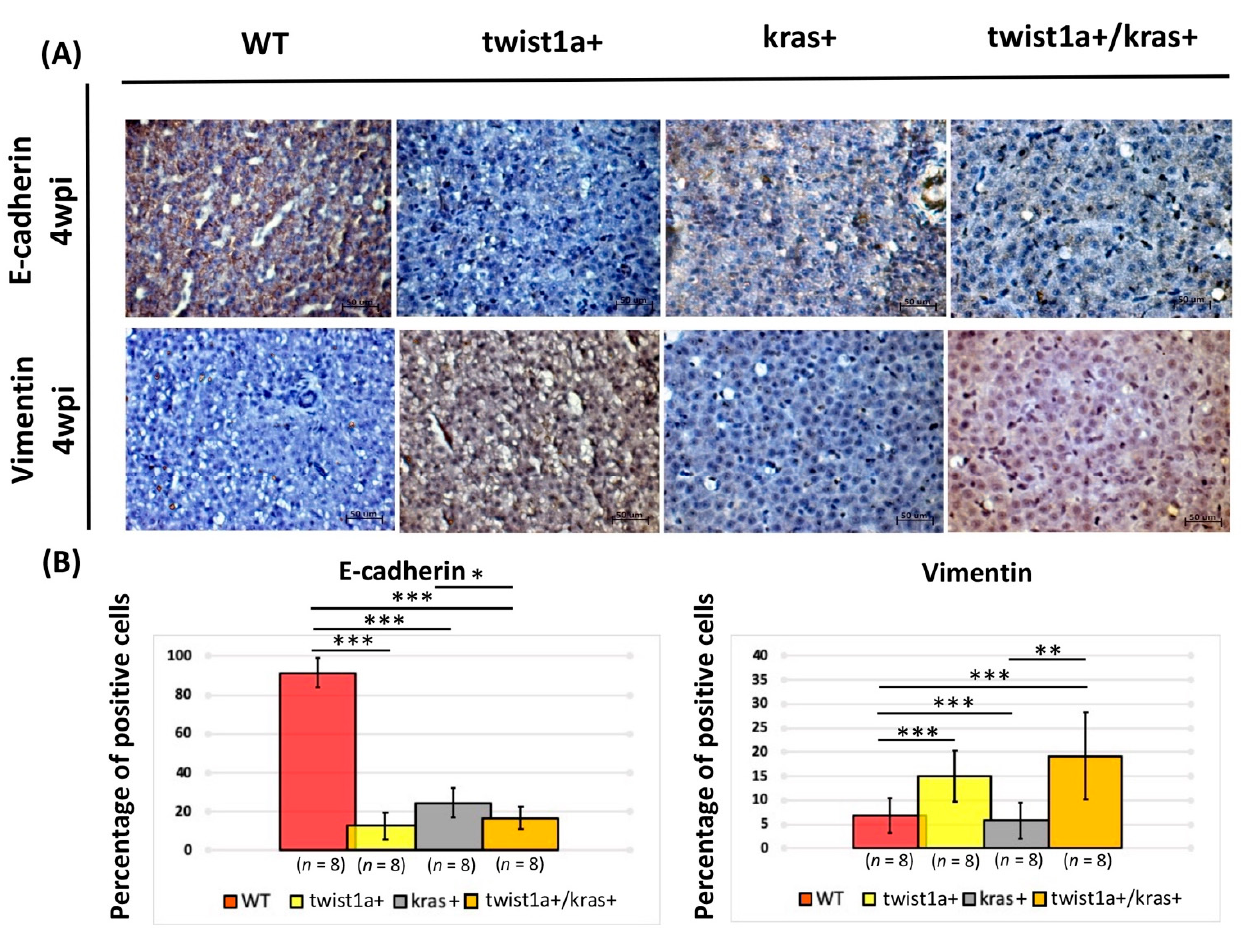
Figure 4. Main EMT hallmarks E-cadherin and Vimentin in liver tissues from twist1a+/kras+ double transgenic zebrafish. ( A ) Immunohistochemical staining micrograph showing E-cadherin and Vimentin-positive cells in liver cross-sections of wild-type, twist1a +, kras +, and twist1a+/kras+ zebrafish. ( B ) Quantification of the percentage of E-cadherin and Vimentin-positive cells for all fields following staining at 4 wpi using ImageJ. Scale bar: 50 μ m. Student’s t -tests were used to assess differences between variables: * p < 0.05, ** p < 0.01, *** p < 0.001.